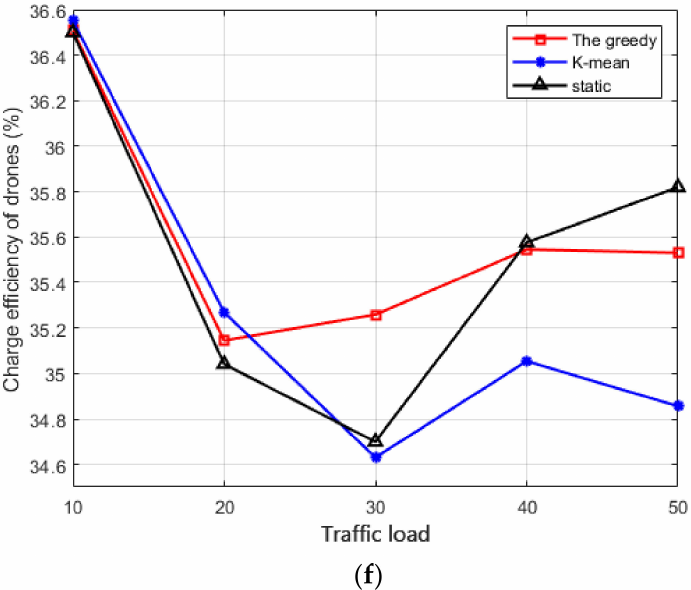
Figure 12. Comparison of the performance metrics under different traffic loads: ( a ) lifetime, ( b ) the percentage of nodes being charged in time, ( c ) the percentage of nodes being charged late by drones, ( d ) the average move time of drones, ( e ) the charge efficiency of all vehicles, and ( f ) the charge efficiency of drones.